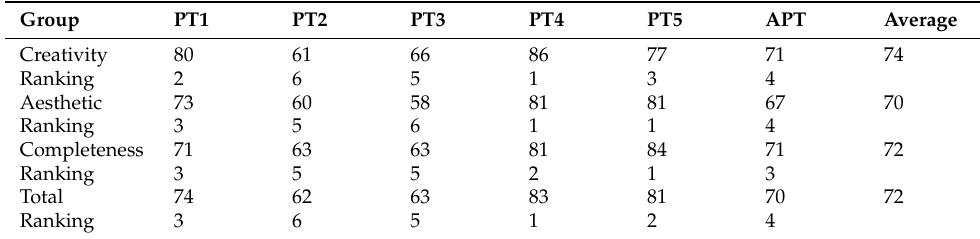
Table 1. Scores of Personality Trait Groups’ Works.